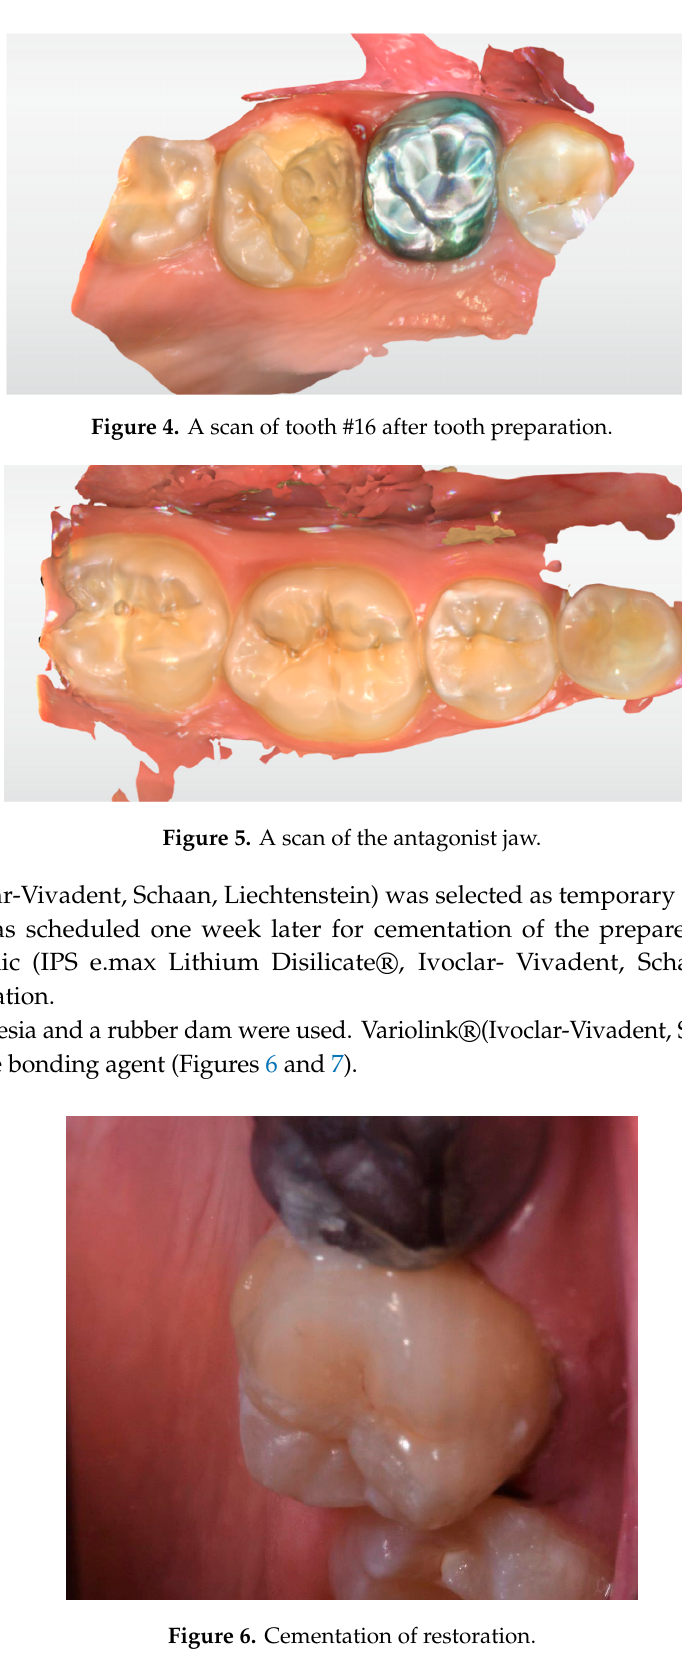
Figure 7. Cementation of restoration. One week later, at the follow-up appointment, the restoration was inspected clinically for the integrity of marginal fit and occlusion. An X-ray was obtained for the determination of marginal integrity and correct fit of the restoration (Figure 8).